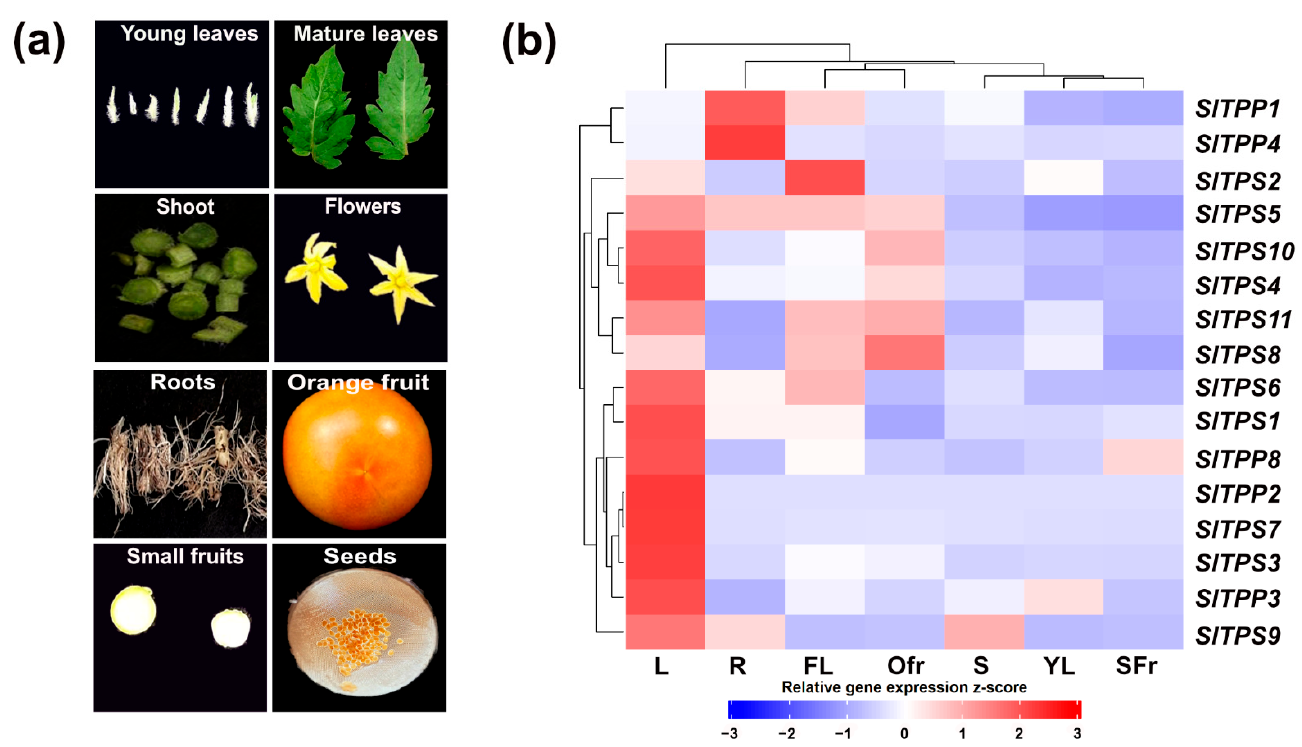
Figure 6. Tissue-specific expression of tomato TPS/TPP genes. ( a ) Representation of tissues sampled for RNA extraction. ( b ) Heatmap of gene expression. L = mature leave; R = root; FL = flower; Ofr = orange fruit; S = stem; YL = young leave; SFr = small fruit. The experiment was carried out at least three times with similar results.